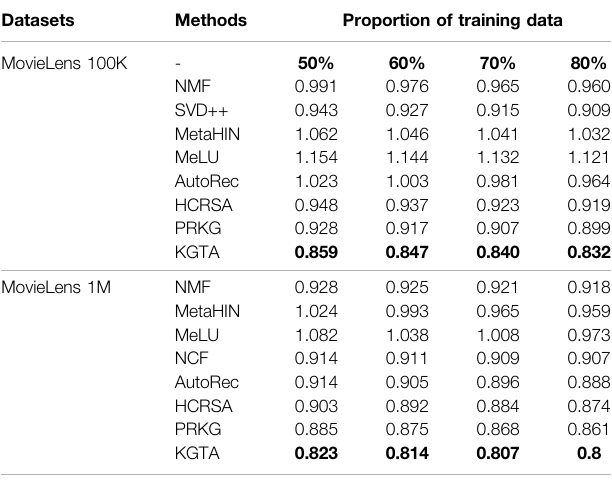
TABLE 3 | The performance of RMSE on MovieLens 100K and MovieLens 1M datasets. Datasets